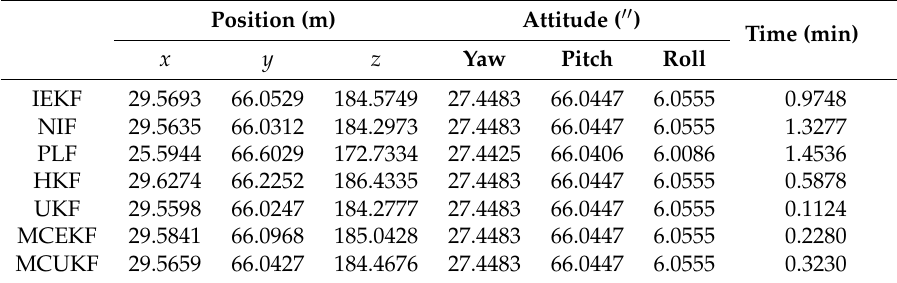
Table 5. RMSE of position, attitude, and time cost of different methods in the presence of Gaussian noise for SINS/CNS deeply integrated